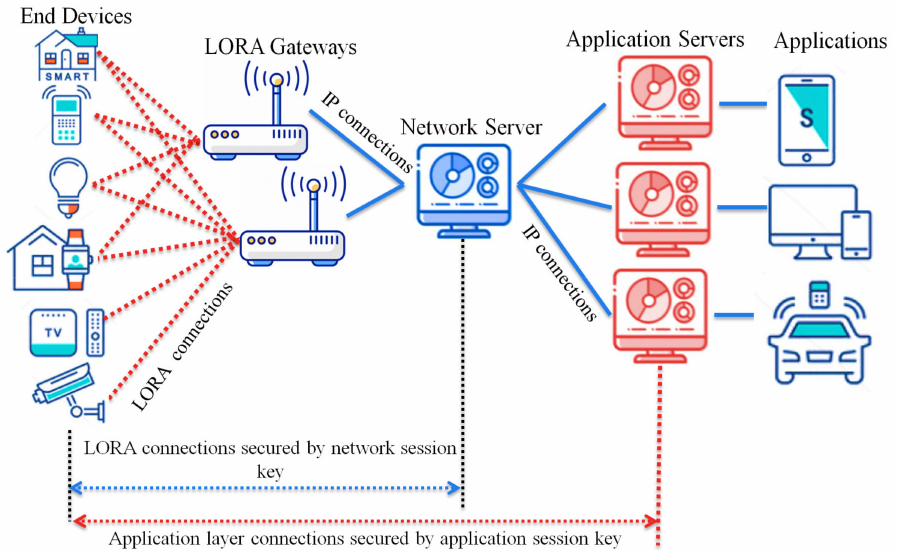
Figure 1. Network architecture of